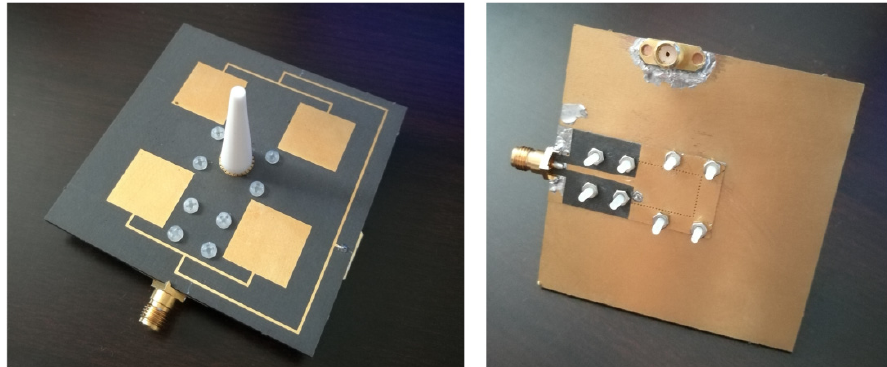
Figure 11. Photograph of the fabricated antenna. Left side is the top view and right side is the bottom view. bottom view.